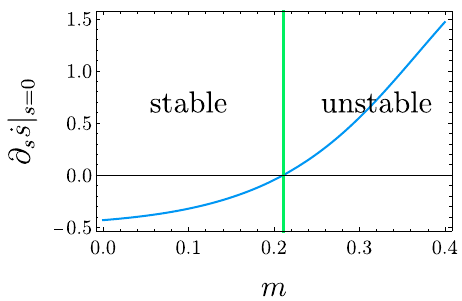
Fig. 4 Stability of the order parameter. The stability of the fl ow on the symmetry line s = 0, ∂ _ s ∂ s j s ¼ given in Eq. (22) for h = 0.5, T b = 0.2. The 0 ; m green vertical line separates between the stable and the